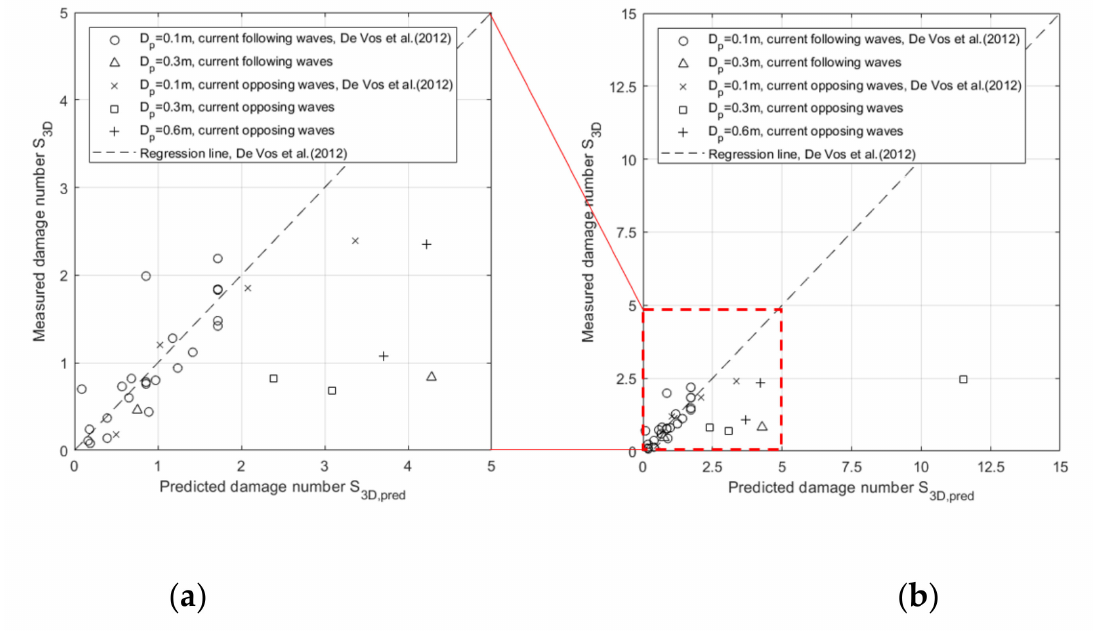
Figure 12. Comparison between predicted damage number S 3 D , pred and measured damage number S 3 D .